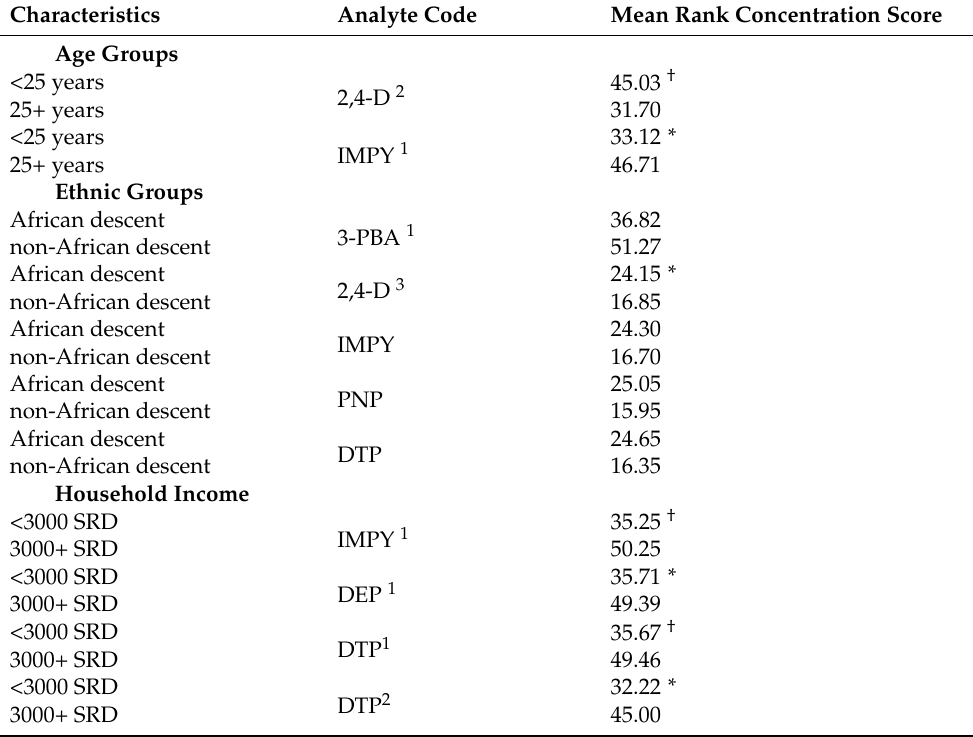
Table 4. Associations between urinary pesticide metabolite concentrations and demographic